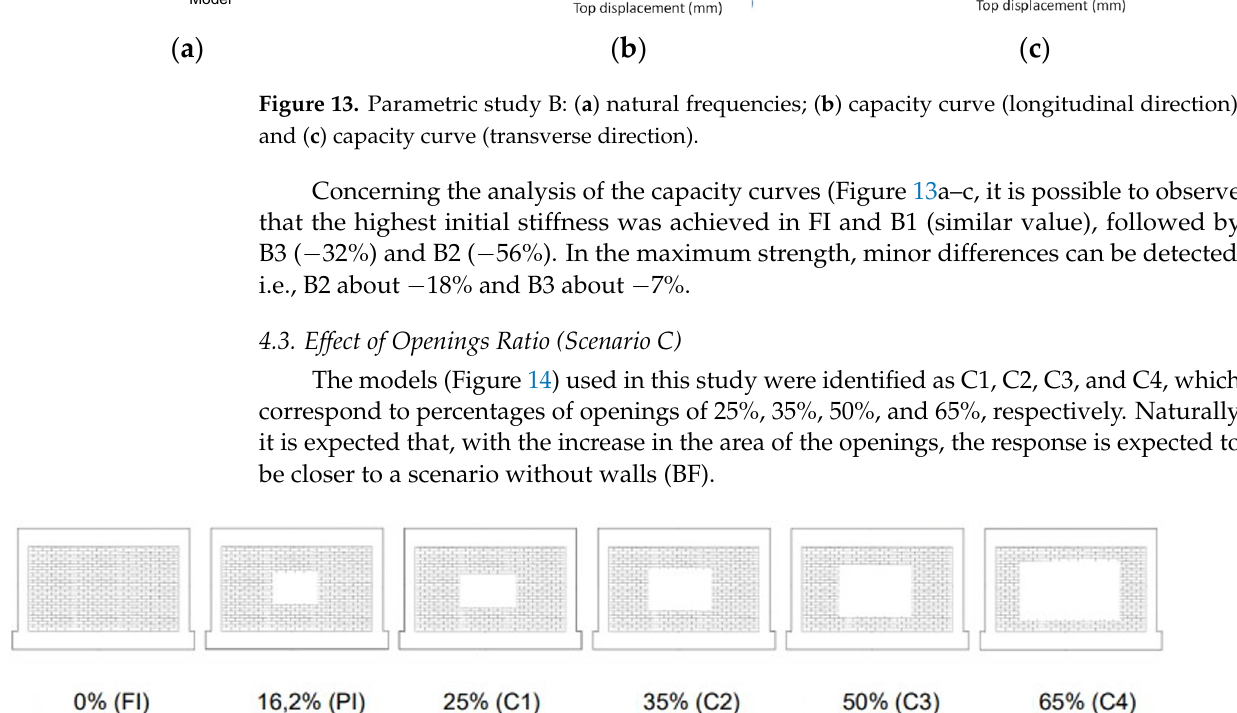
Figure 14. Models under study in Scenario C.